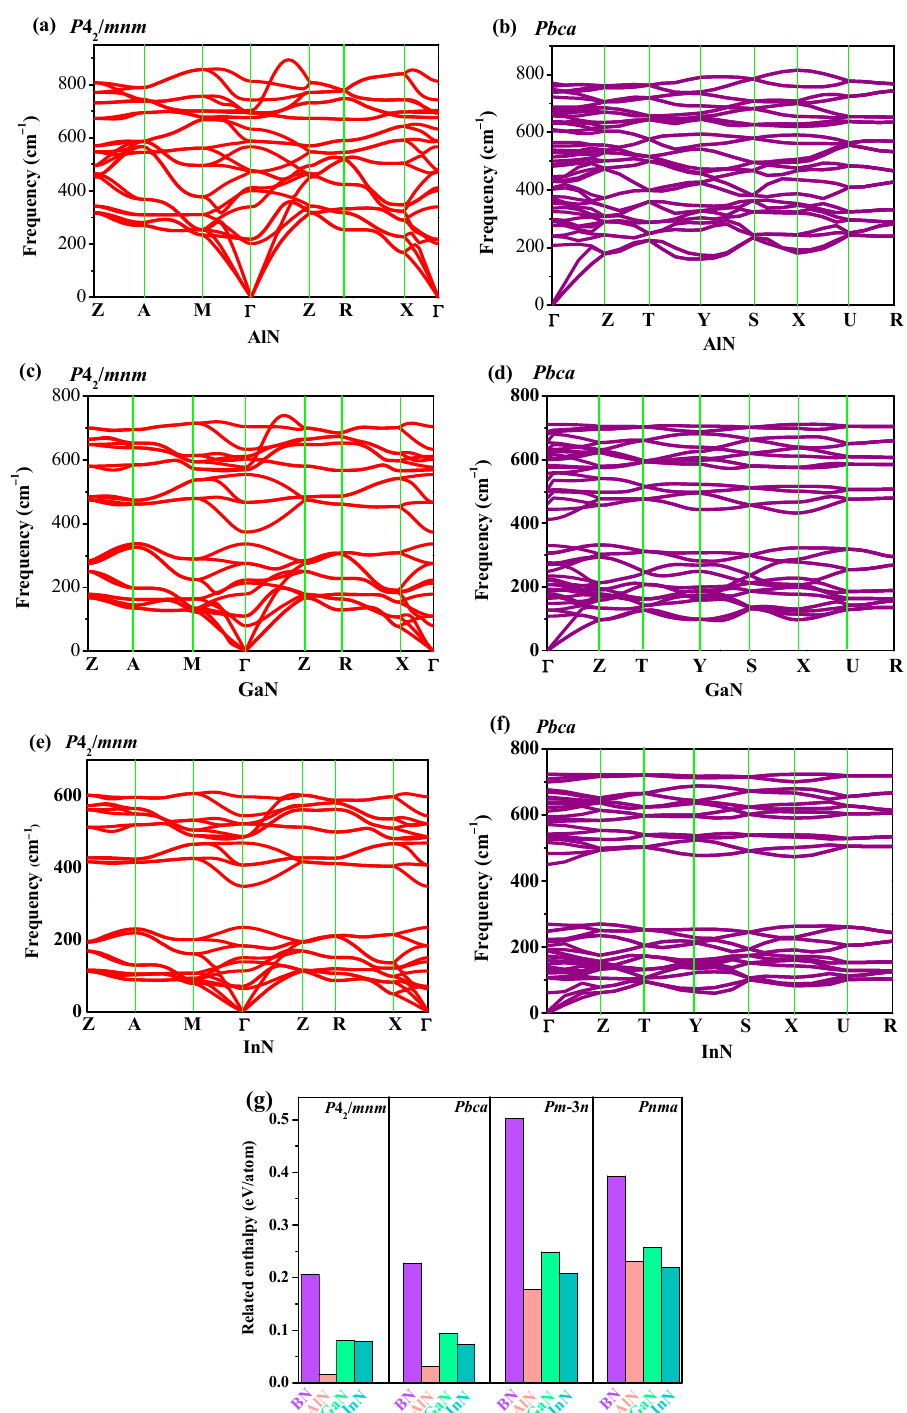
Figure 2. Phonon dispersion branches of AlN ( a ), GaN ( c ), and InN ( e ) in the P 4 2 / mnm phase, phonon dispersion branches of AlN ( b ), GaN ( d ), and InN ( f ) in the Pbca phase, and related enthalpies ( g ) of XN in the P 4 2 / mnm , Pbca , Pm -3 n and Pnma phases.